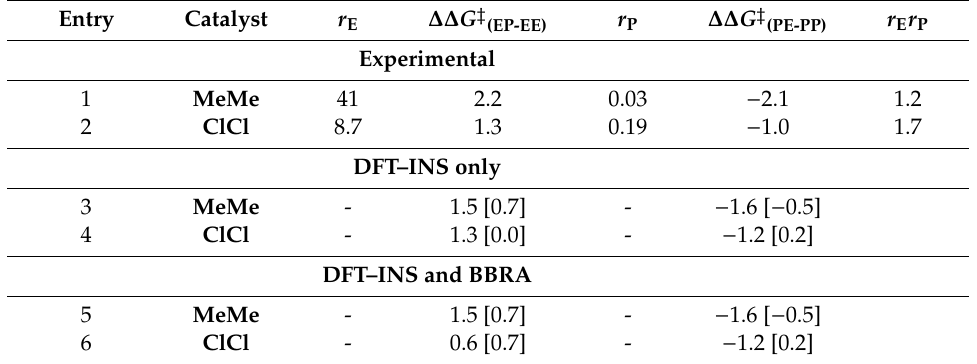
Table 3. Experimental r E and r P for MeMe and ClCl in ethene / propene copolymerization and comparison between corresponding experimental and DFT calculated ∆∆ G ‡